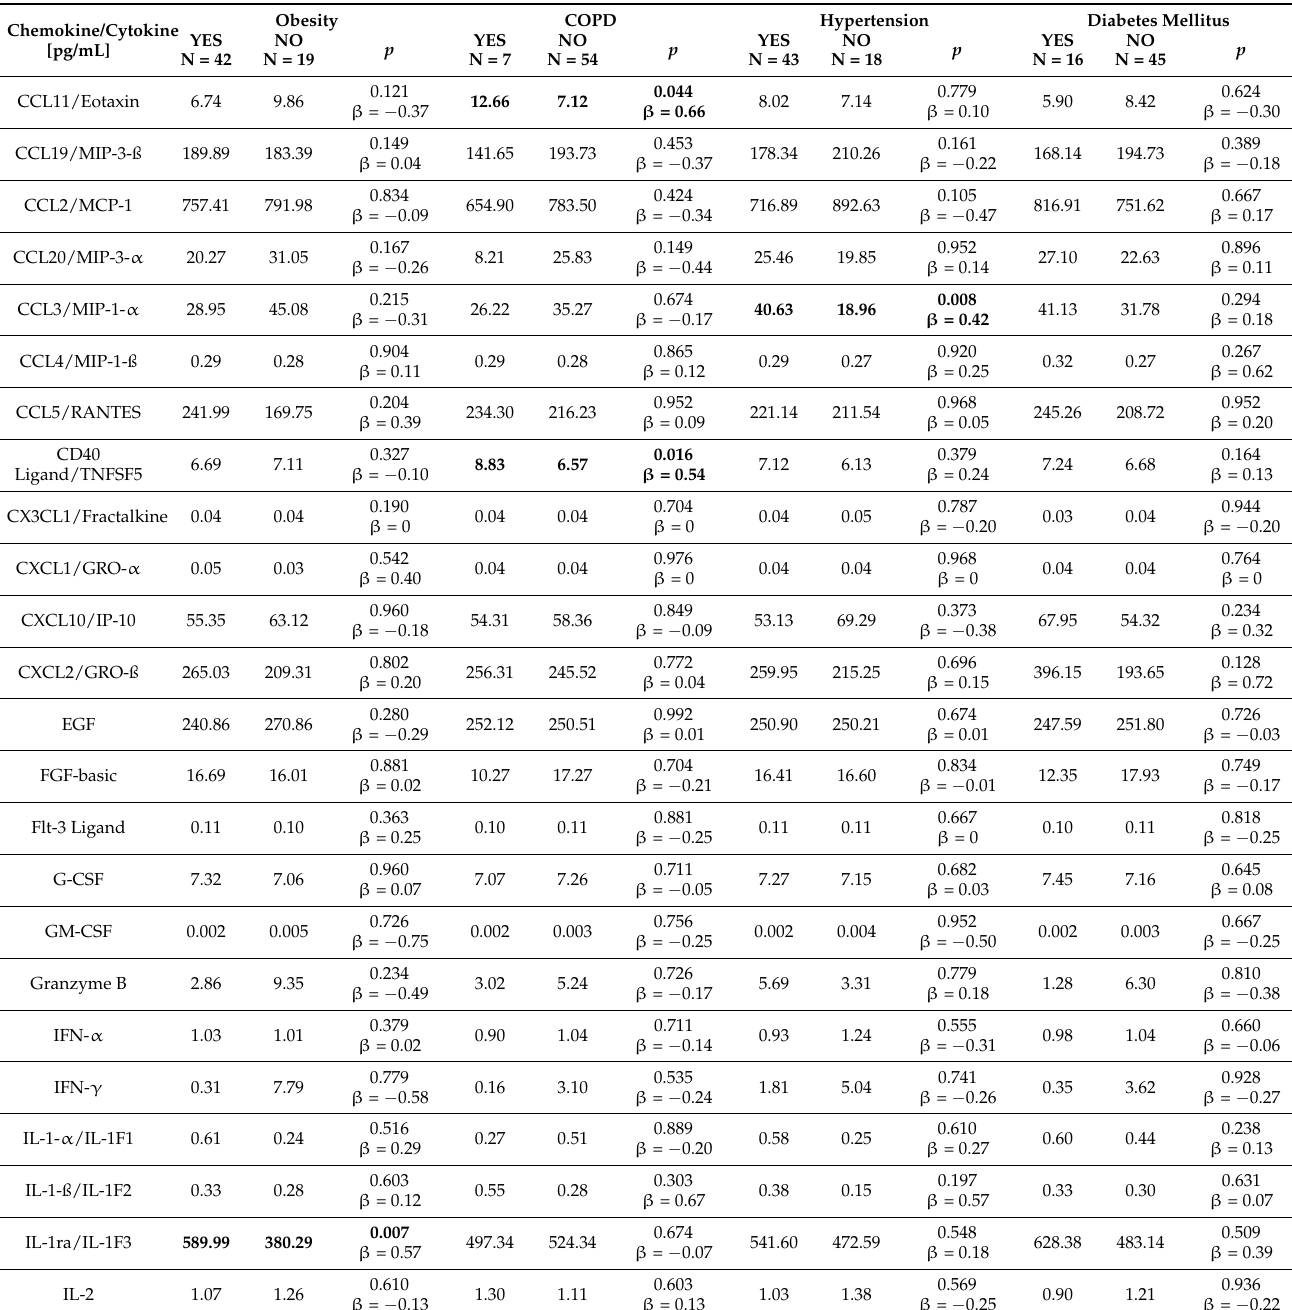
Table 4. Concentrations of chemokines/cytokines in the groups of OSA patients with and without